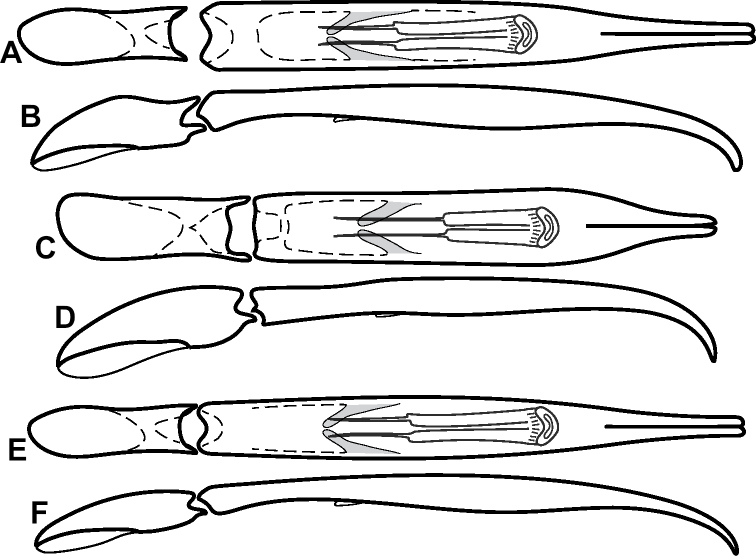
Male genitalia A, BPhelister
incongruens: A aedeagus, dorsal B aedeagus, lateral C, DP.
congruens: C aedeagus, dorsal D aedeagus, lateral E, FP.
praesignis: E aedeagus, dorsal F aedeagus, lateral.